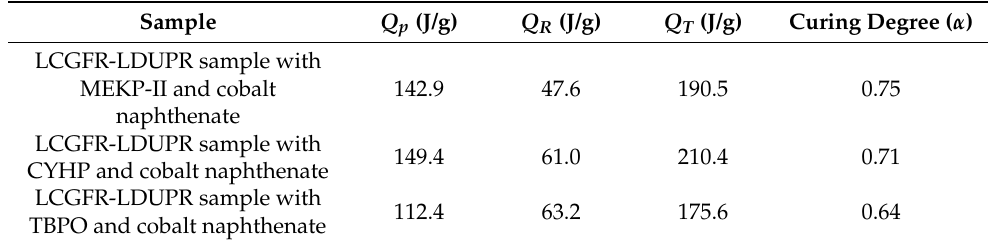
Table 6. Curing degrees of unsaturated polyester resin with presences of different